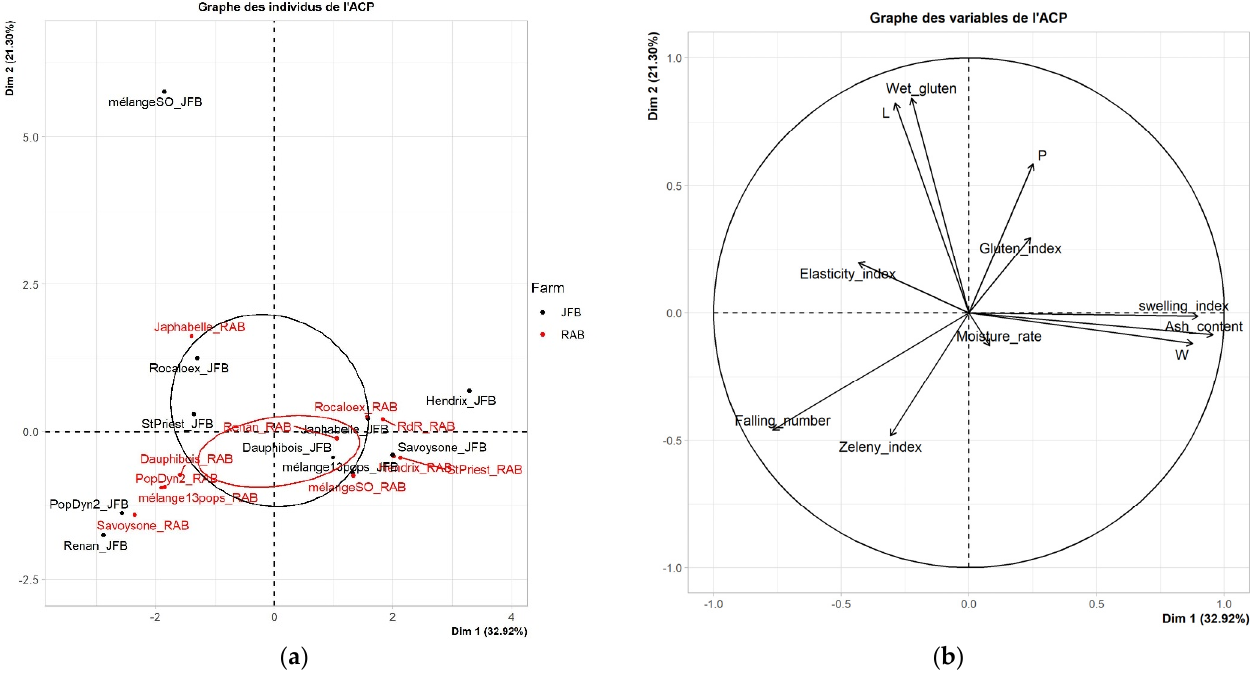
Figure 3. Results of the PCA on technological variables: ( a ) graph of individual and ( b ) correlation circle.